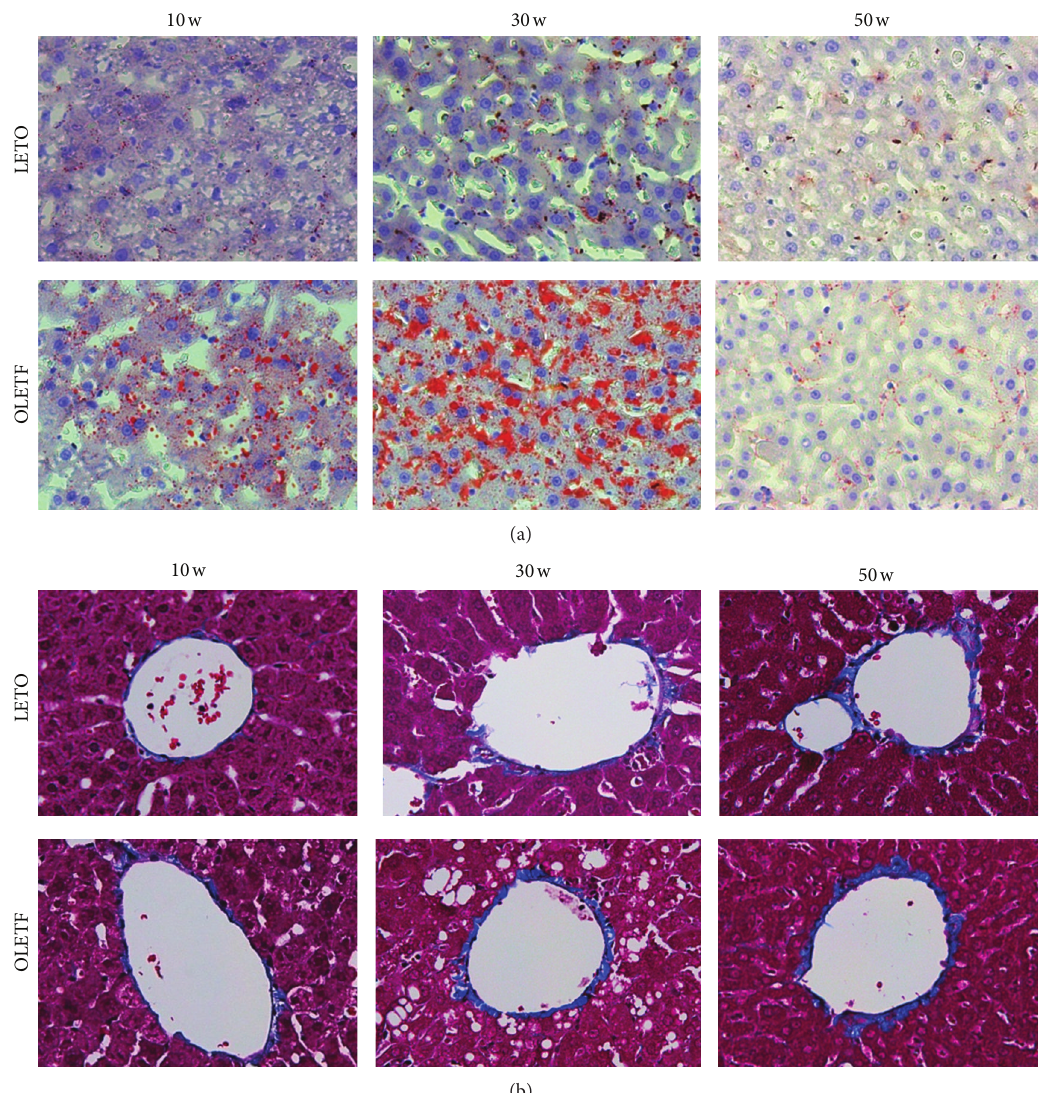
Figure 3: Liver histology. Representative images of Oil Red O (a) and Masson’s trichrome (MT) staining (b) of the livers at 10, 30, and 50 weeks of age (magnification, × 400).